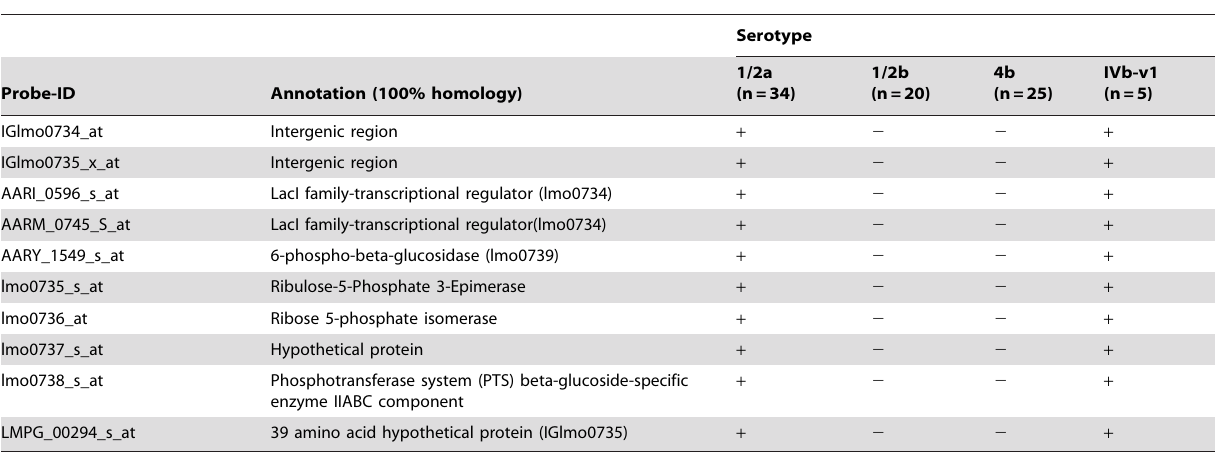
Table 4. Unique probe-sets in 1/2a and IVb-v1 L. monocytogenes strains.